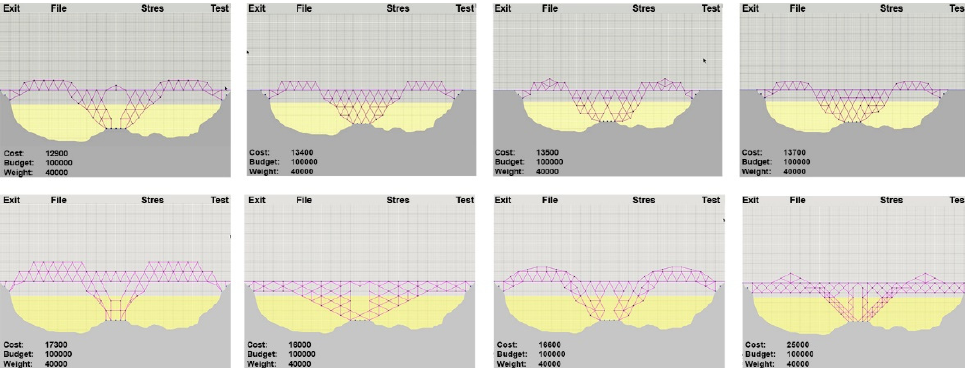
Figure 3. Examples of competition bridges made by students in BridgeBuilder.